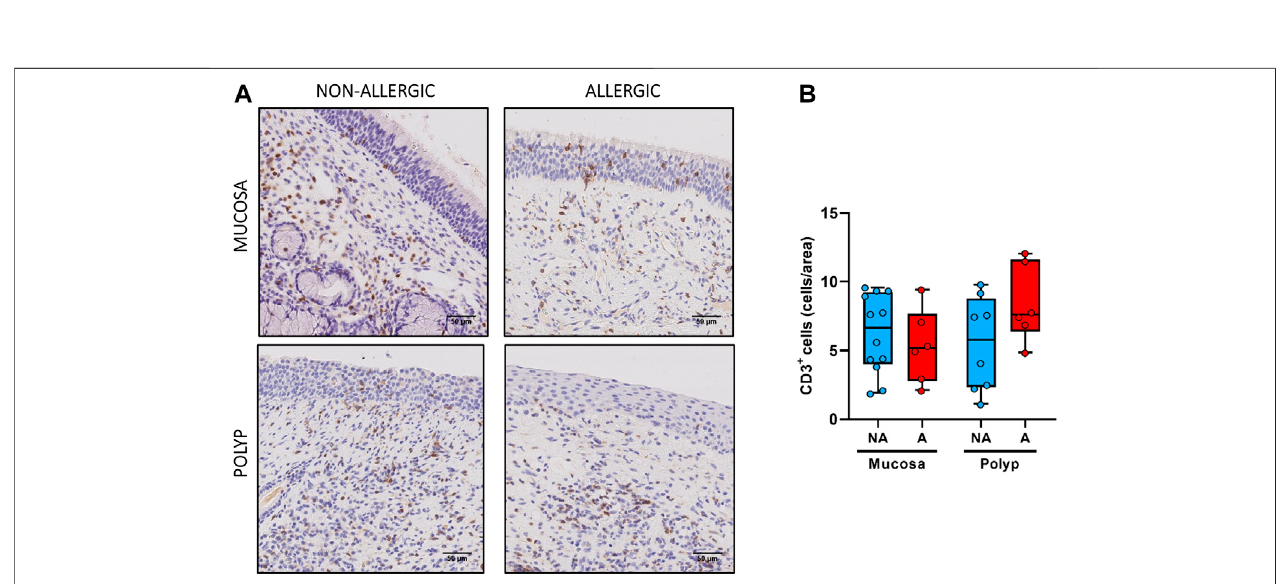
FIGURE 8 | Analysis of CD3 + cells in fi ltrates in nasal polyps and nasal mucosa. (A). Representative images of anti-CD3 immunostaining in nasal mucosa ( n (cid:2) 18) andnasalpolyps( n (cid:2) 14)inallexperimentalgroups(CD3 + cells:blackarrow → ,scalebar (cid:2) 50 μ m). (B). ComparisonofthenumberofCD3 + cellsperareainnasalpolyps and nasal mucosa samples between non-allergic CRSwNP (NA) and allergic CRSwNP (A) patients. Results are presented as mean ± SEM. Mann-Whitney U test was used to state signi fi cant